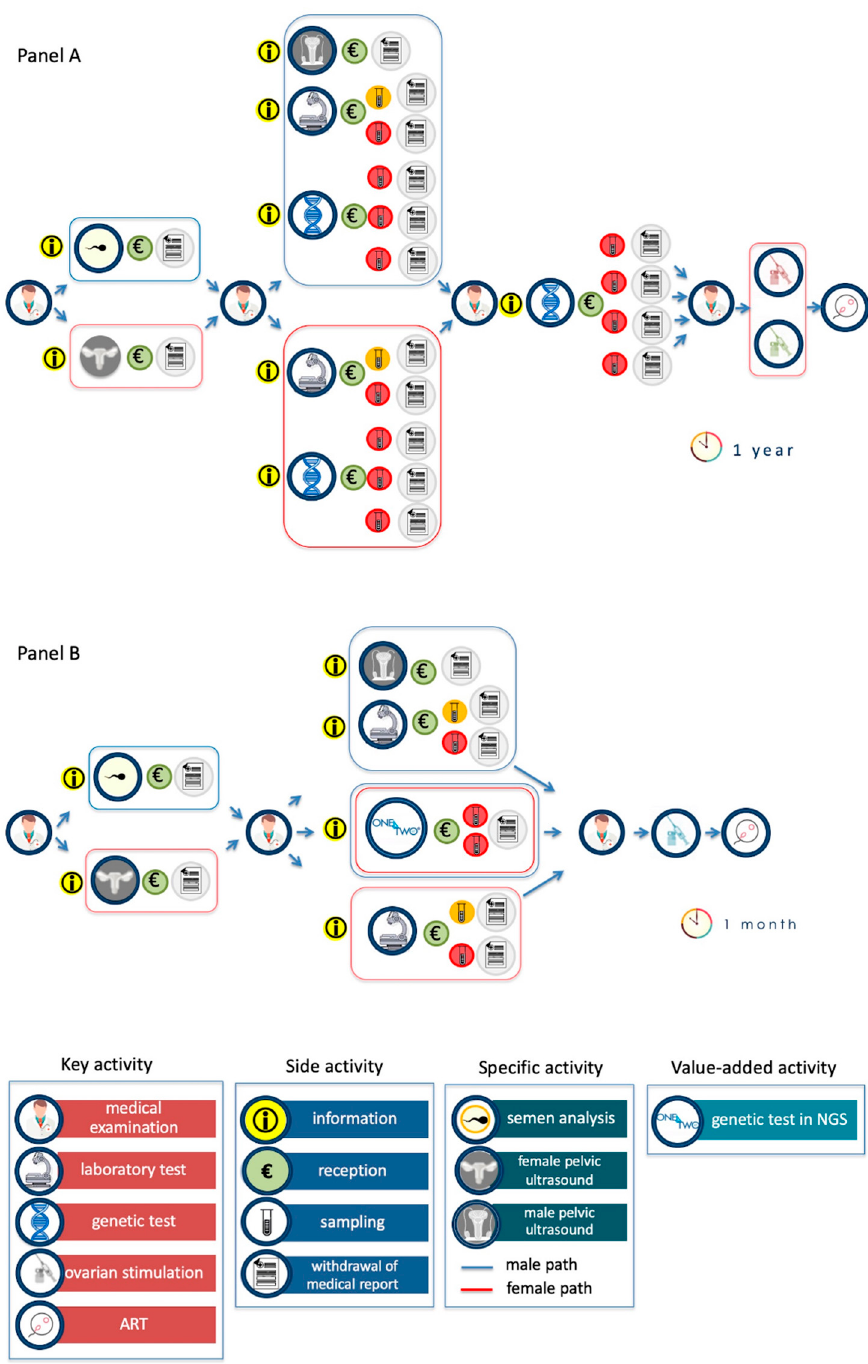
Figure 4. Comparison between infertile couples’ journey before ( A ) and after ( B ) the introduction of One4Two ® . Some of the key operations, such as the three medical visits, the five traditional diagnostic investigations and the point of arrival (ART), remain unchanged with the introduction of One4Two ® . However, the simplification of the key and side operations regarding molecular genetic diagnostics is evident. The execution of the test using NGS-technologies allows, not only to unify the analysis of genes related to infertility and that of disease-genes, but also to carry out the analysis simultaneously in both partners. Additionally, side actions are streamlined, as the collection of information and administrative practices are reduced from 8 to 6, the collection of biological samples is reduced from 17 to 8, and medical reports are reduced from 14 to 6. In ( B ) it is noted that the treatment for ovarian stimulation is beneficial, as the analysis of polymorphisms makes it possible to identify patients who are high or low responders to ovarian stimulation treatments. Finally, the time that elapses from the first medical visit to the ART goes from a year ( A ) to a month ( B